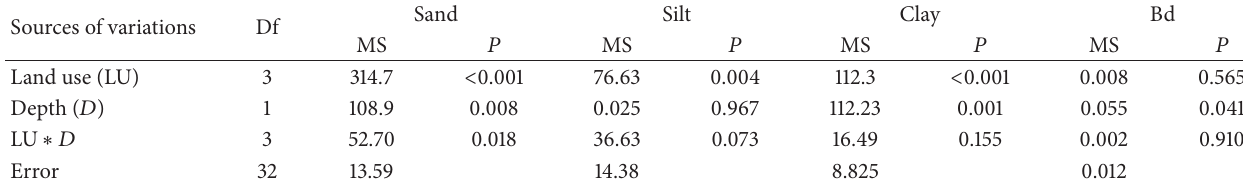
Table 2: Summary of two-way ANOVA for soil textural fractions and bulk density relation to land use and soil depths. Sources of variations